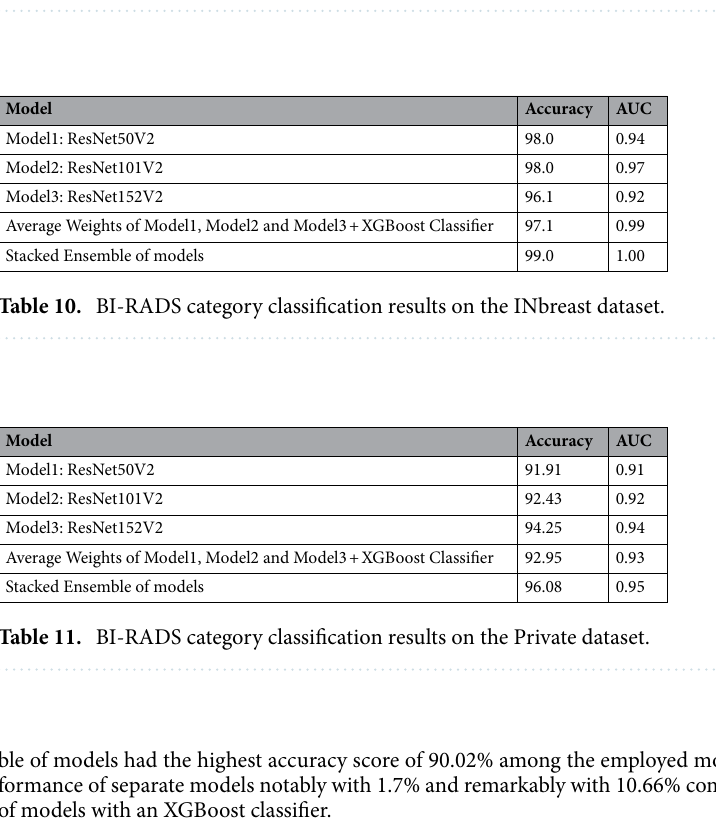
Table 9. BI-RADS category classification results on the CBIS-DDSM dataset.